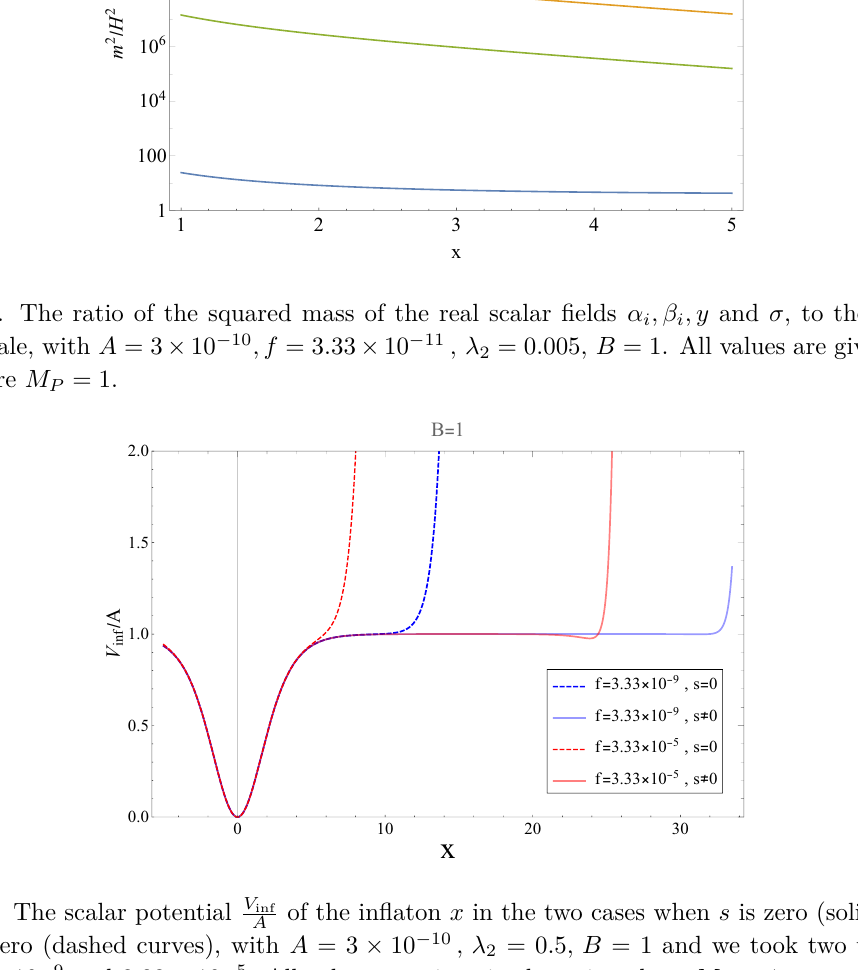
of the inflaton x in the two cases when s is zero (solid curves) Figure 3 . The scalar potential V inf A and non-zero (dashed curves), with A = 3 × 10 − 10 , λ = 0 . 5 , B = 1 and we took two values for 2 f = 3 . 33 × 10 − 9 and 3 . 33 × 10 − 5 . All values are given in the units where M P = 1